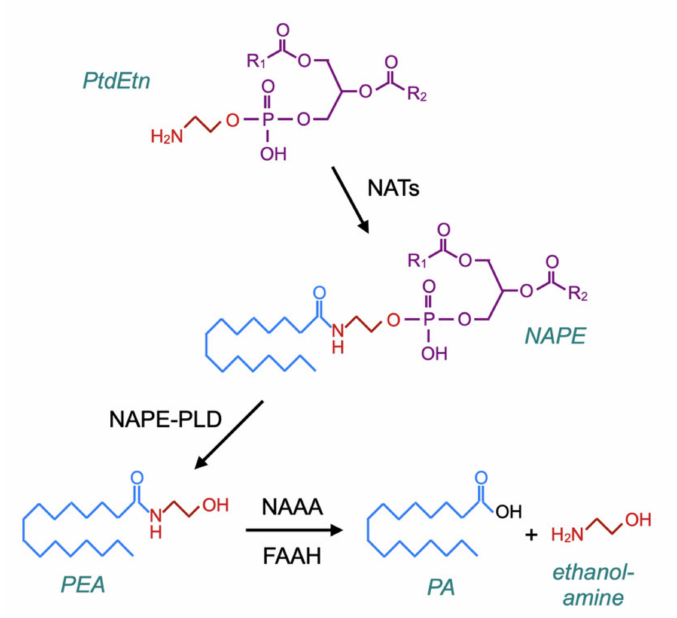
Figure 5. The canonical pathway for the synthesis of PEA via N -acyltransferases (NATs) and N -acylphosphatidylethanolamines (NAPE)–phospholipase D. The catabolism of PEA is also shown in